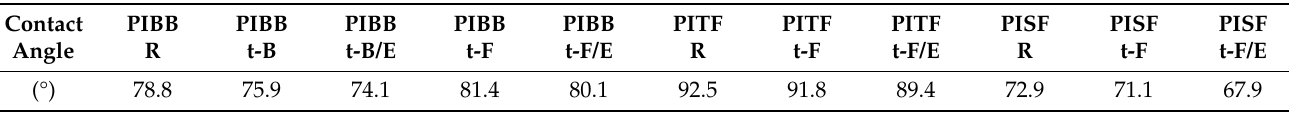
Figure 9. Contact angle images of water droplets on films ( A ) and contact angle comparison of the PIBBs, PITF S, and PISFs films ( B ). Table 6. Contact angles of PIBBs, PITFs, and PISFs.